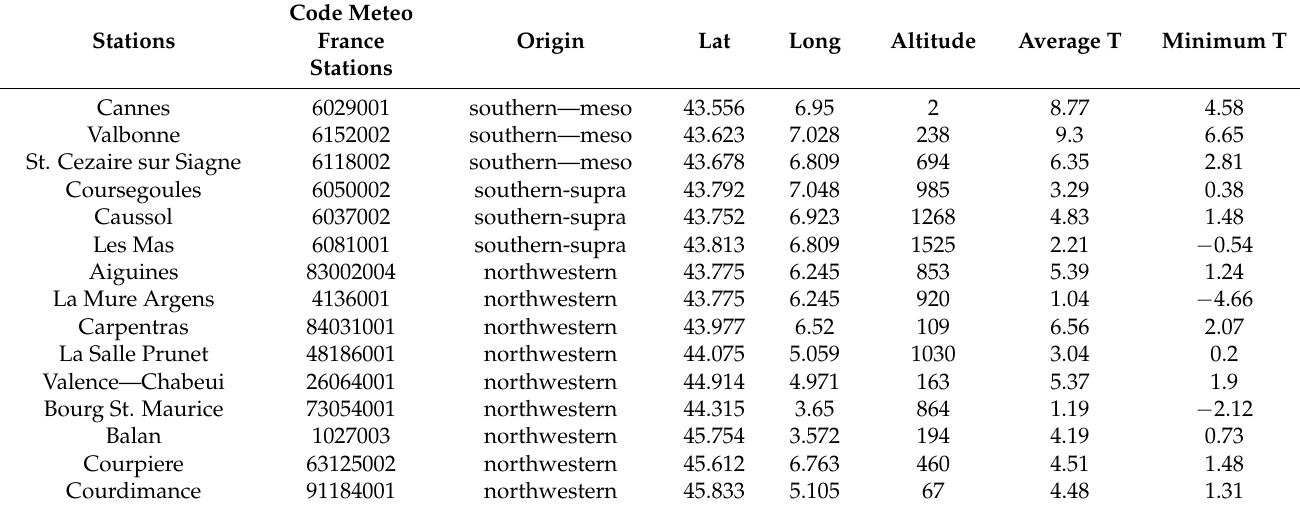
Table 2. Summary of reference weather stations and daily mean (average T) and minimal (minimum T) temperatures observed during the three coldest months (December −